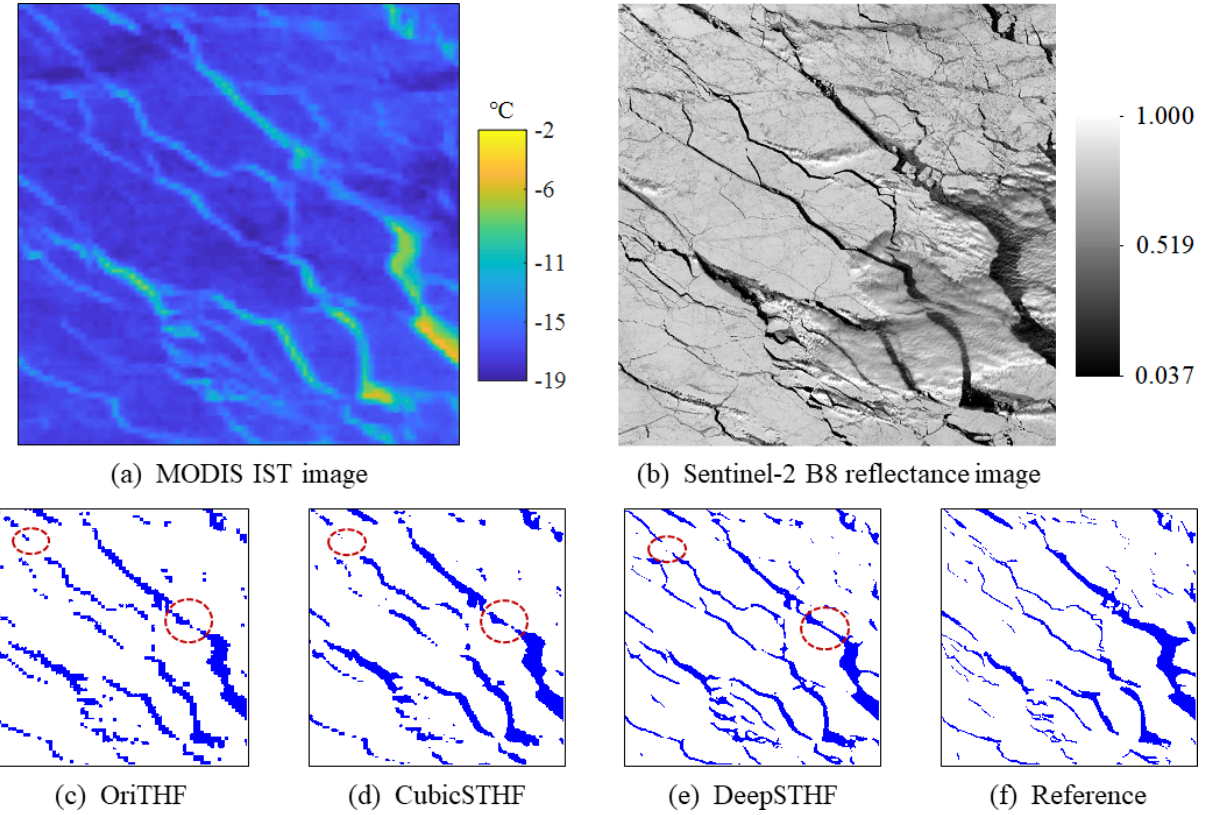
Figure 15. (a) The MODIS IST image of a subarea in the Barents Sea; (b) the Sentinel-2 B8 reflectance image; (c) the lead map obtained from the MODIS IST image by the OriTHF method; (d) the lead map obtained from the MODIS IST image by the CubicSTHF method; (e) the lead map obtained from the MODIS IST image by the DeepSTHF method; (f) the reference lead map extracted from the Sentinel-2 image. The red ellipse in panel (e) represents the area impacted by the drifting snow.